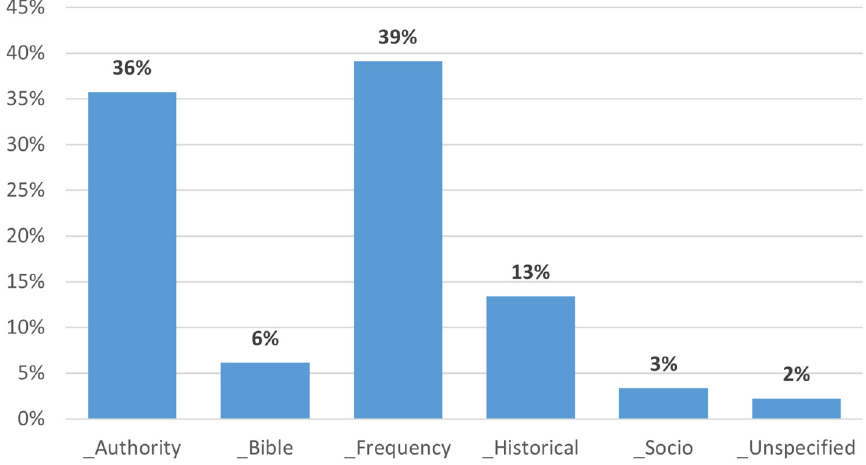
Figure 8. Relative frequency of the lower-level categories within the top-level category U SE (% of total number of U SE arguments, n = 179).